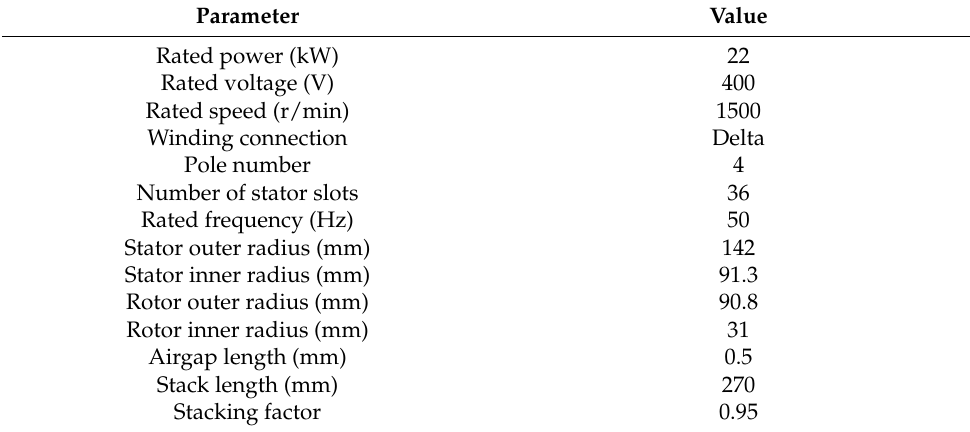
Table 1. Details of the analyzed